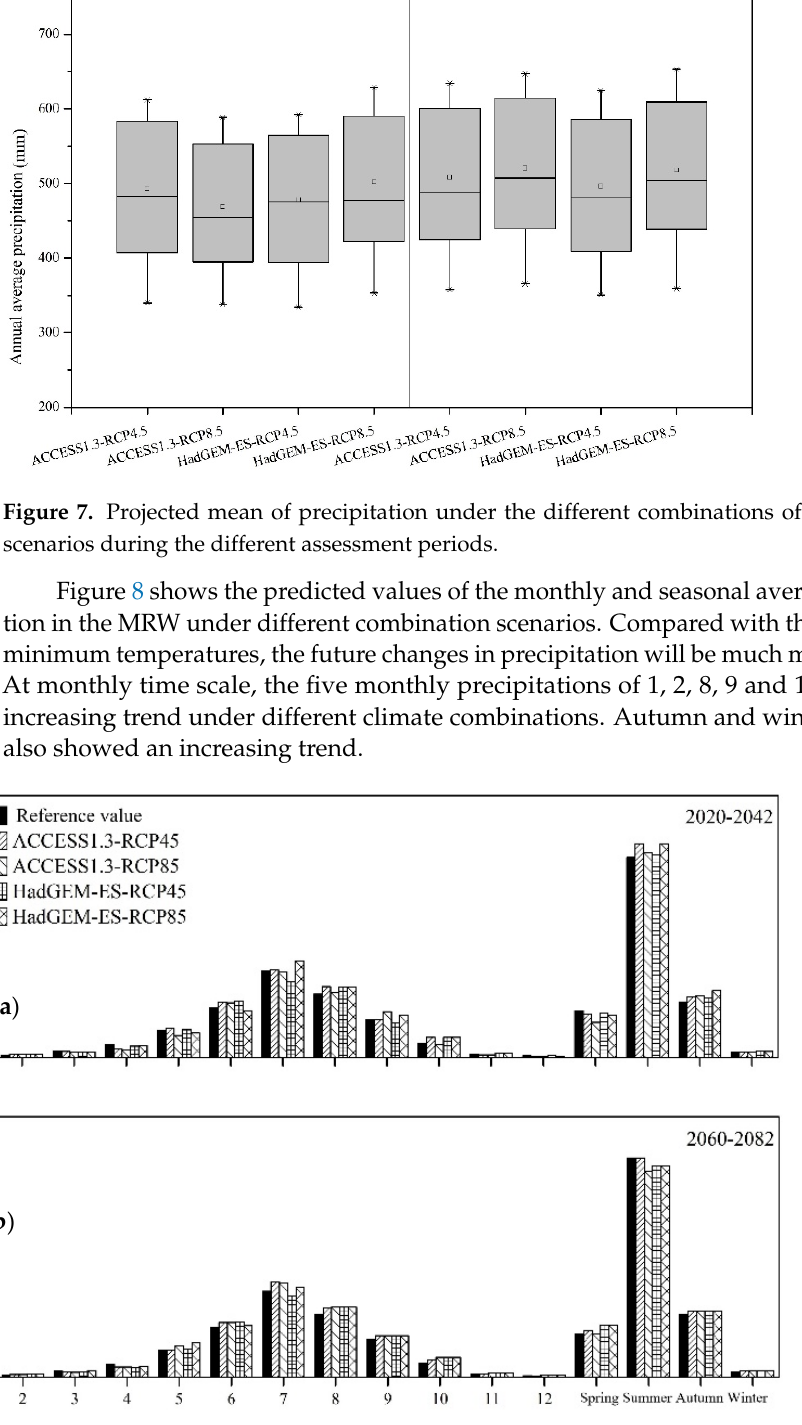
11 of 23 Figure 6. Projected values of minimum temperature under the different combinations of GCMs and RCPs scenarios during the different assessment periods ( a ) from 2020 to 2042; ( b ) from 2060 to 2082.